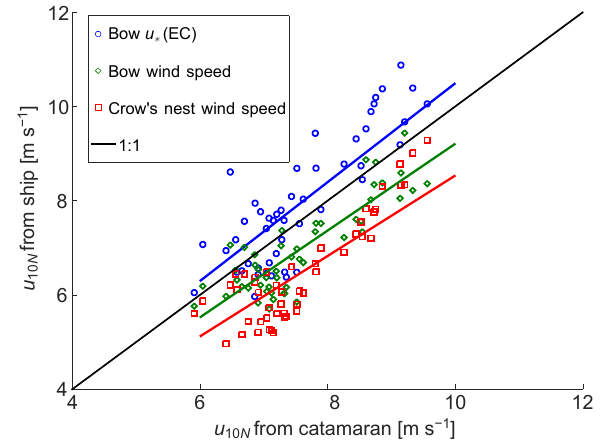
Figure 6. CO 2 gas transfer velocity normalised to Sc = 660 as a function of u ∗ . Shown are the direct EC estimates prior to and af- ter the application of the regression corrections to the CO 2 mixing ratios and wind-speed measurements. The lines show linear fits of k 660 (u ∗ ) against u ∗ . The linear regression explained 83% of the EC results with the regression corrections applied and 35% without regression